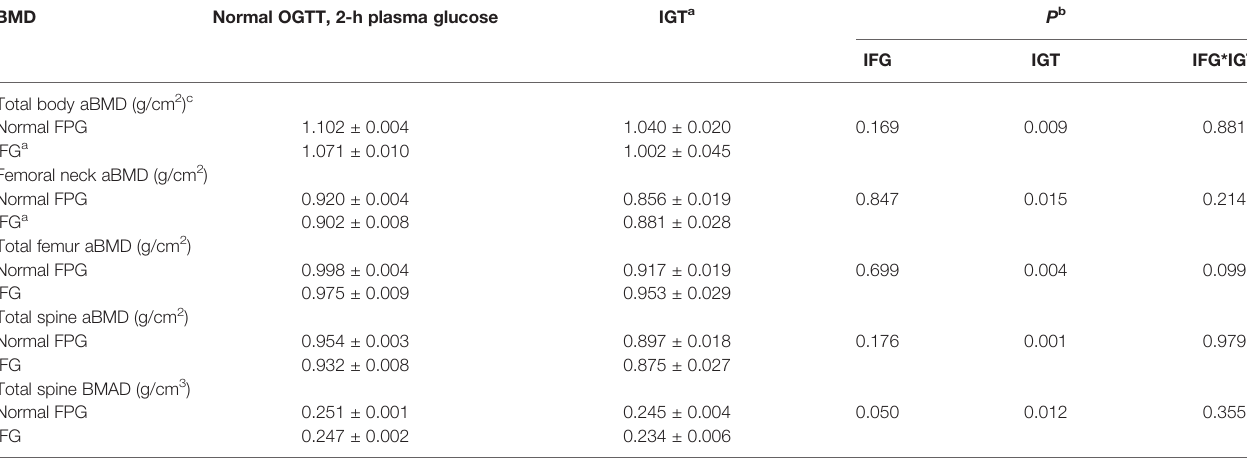
TABLE 2 | Multivariate-adjusted means for bone mineral density across phenotypes of